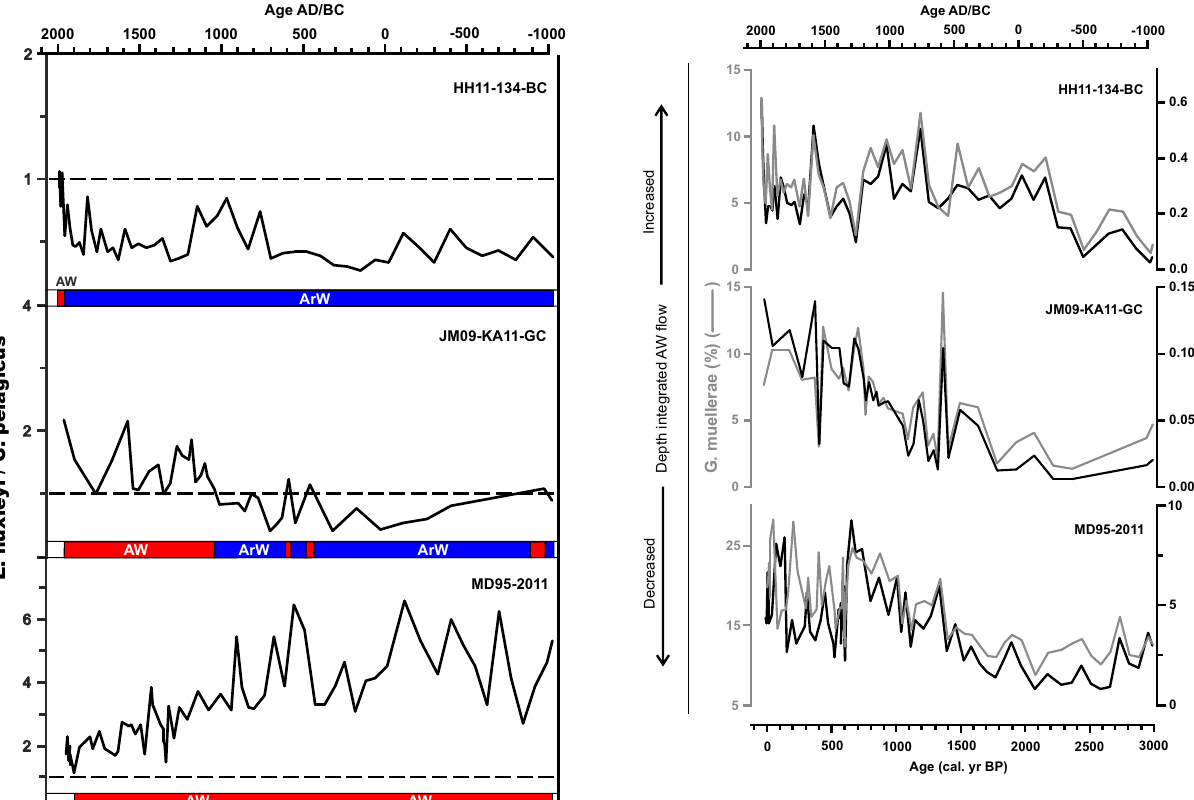
Fig. 6. Relative abundances (grey line) and absolute concentrations (black line) of the AW inflow species G. muellerae , throughout the three studied cores. The MD95-2011record is a late Holocene zoom of previously published data by Giraudeau et al.